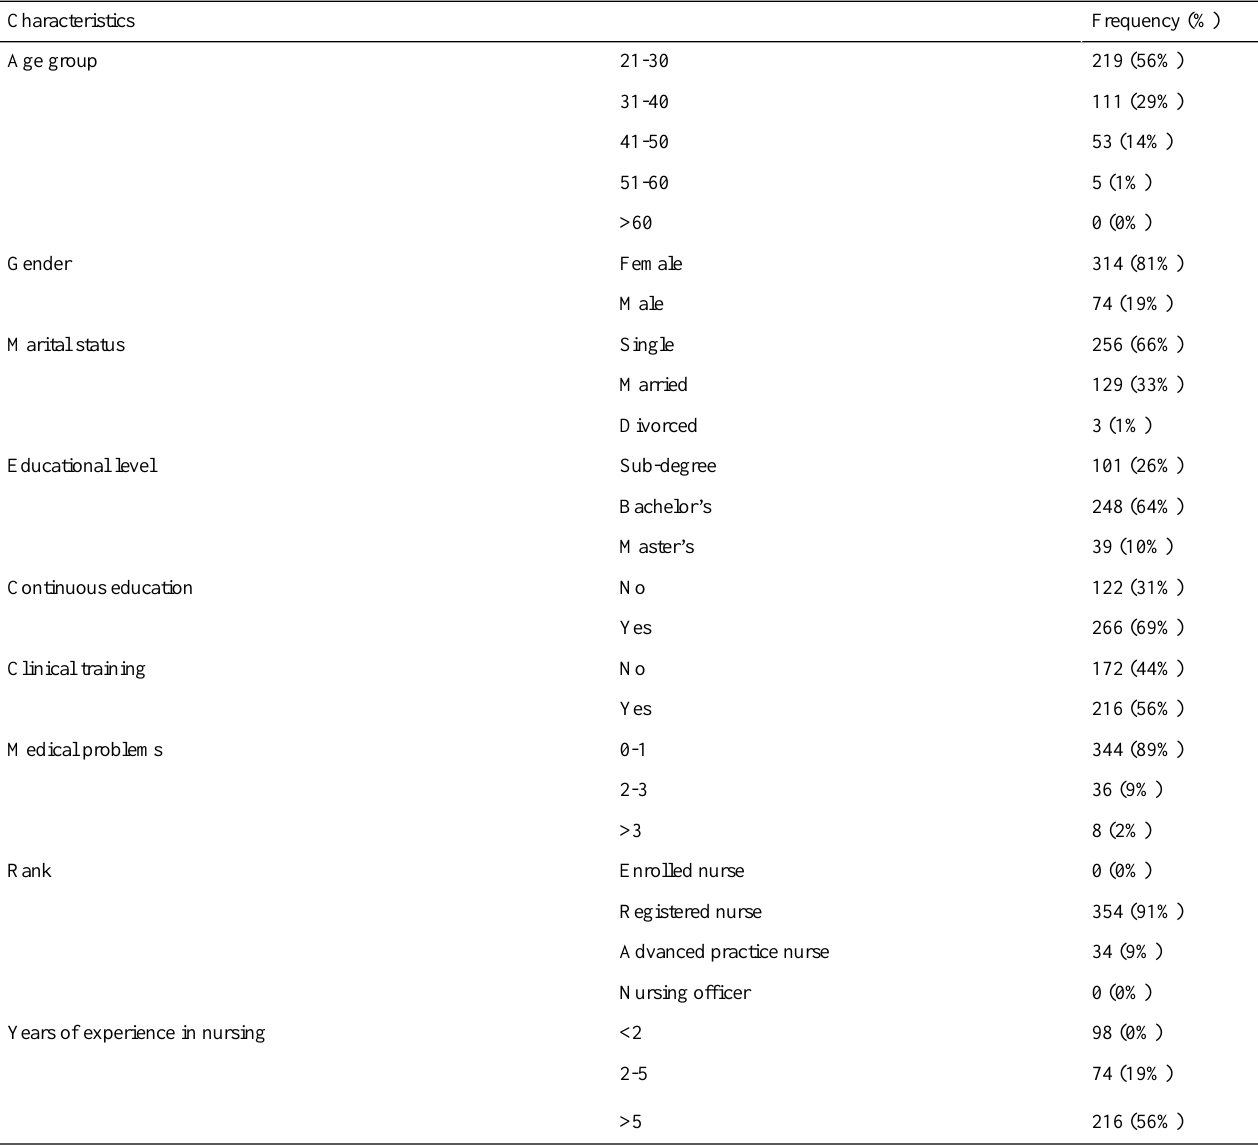
Table 3. Demographic characteristics of the sample (n =